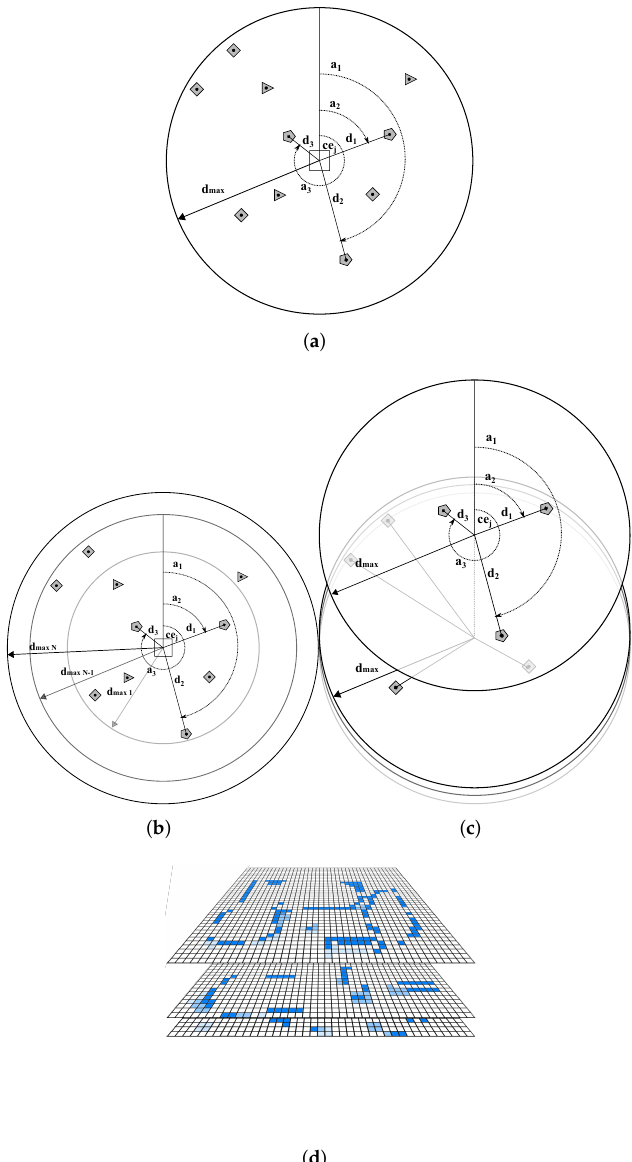
Figure 4. The four encodings presented in this work. All of them quantify the geospatial vector data differently: ( a ) shows the GSCM which was introduced by [4] (image source: [4]); ( b ) shows the layered GSCM (LGSCM) which computes descriptive statistics for different ring regions. For each ring region descriptive values are computed for each OWL class; ( c ) shows the channel GSCM (CGSCM) which provides a channel-wise representation of the descriptive values. In ( a – c ) the different geo-object types (OWL classes) are indicated by different shapes; ( d ) shows the CUBE encoding which represents the geographic distribution of each geo-object type as a heatmap. In this visualization, only three of multiple heatmaps are shown. Each heatmap represents the geospatial distribution of a specific OWL class. Here, deep blue grid-cells denote a higher number of geo-objects, whereas the color gradient toward white represents a decreasing number of geo-objects.